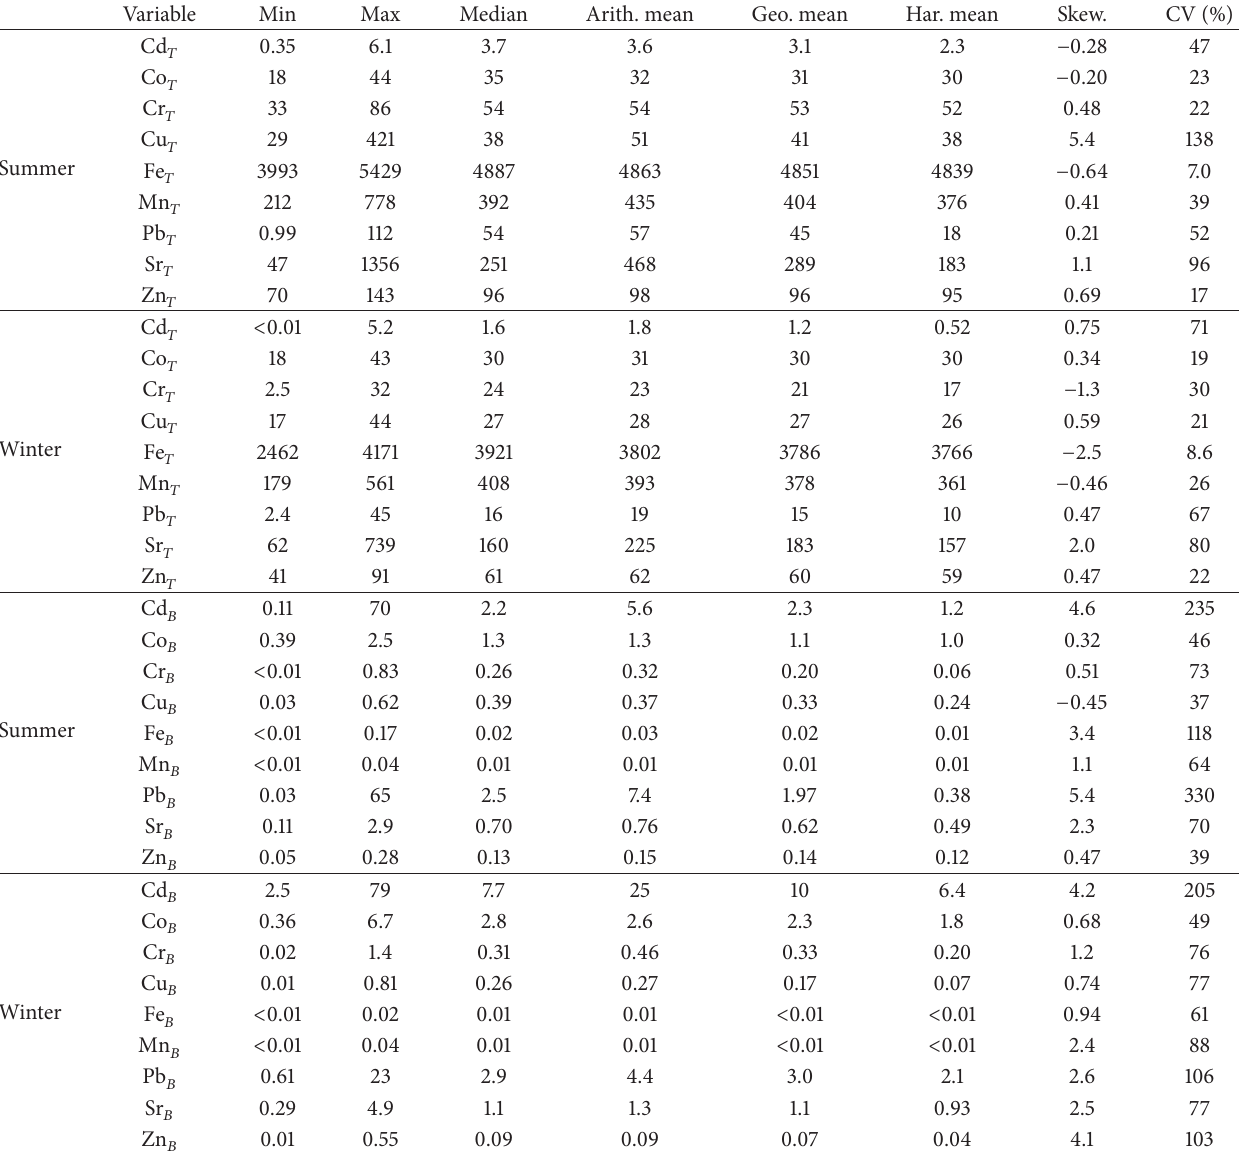
Table 2: Descriptive statistics of pseudototal ( 𝑇 , mg/kg) and bioavailable ( 𝐵 , %) concentrations of selected metals in summer and winter.